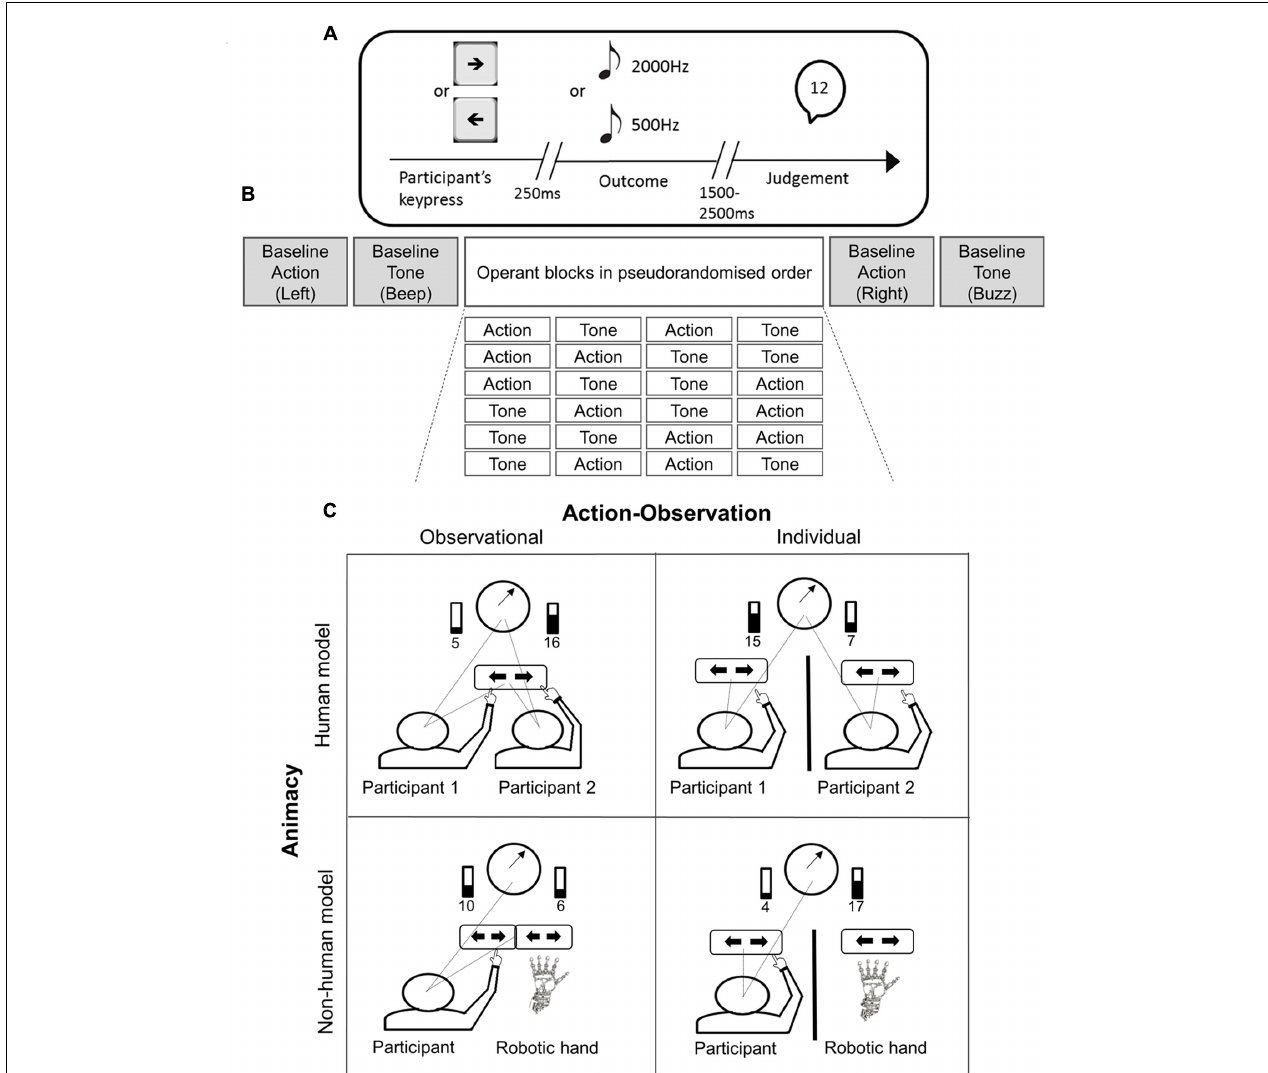
FIGURE 1 | (A) Timeline of an experimental trial. Participants were instructed to press the left or right arrow keys at a time of their own free choice. In the operant conditions, each keypress was followed by a beep (2000 Hz) (rewarded) or a buzz (500 Hz) (non-rewarded) after 250 ms with different probabilities. At the end of the trial, participants reported the perceived time of the action or of the tone. See the text for full explanation. (B) The experimental session started with one Baseline Action and one Baseline Tone block. Four main experimental blocks, 2 Operant-Action and 2 Operant-Tone then followed in pseudorandomised order. All possible block orders are shown. Each pair performed one of the six possible orders. The order of the operant blocks was counterbalanced across participants. The session ended with the execution of the complementary blocks of Baseline Action and Baseline Tone. (C) 2 × 2 factorial design with the factors of animacy (human/robot model) and action-observation (observational/individual). In the human-model groups two participants were seated in front of the screen and alternated in performing trials. One of the participants was replaced with a robotic-hand in the non-human groups. An opaque barrier (thick black line) further divided each group to ‘observational’ and ‘individual’ groups. See the text for full explanation. Progress bars displayed the cumulative total of rewarded trials. Dotted lines represent gaze